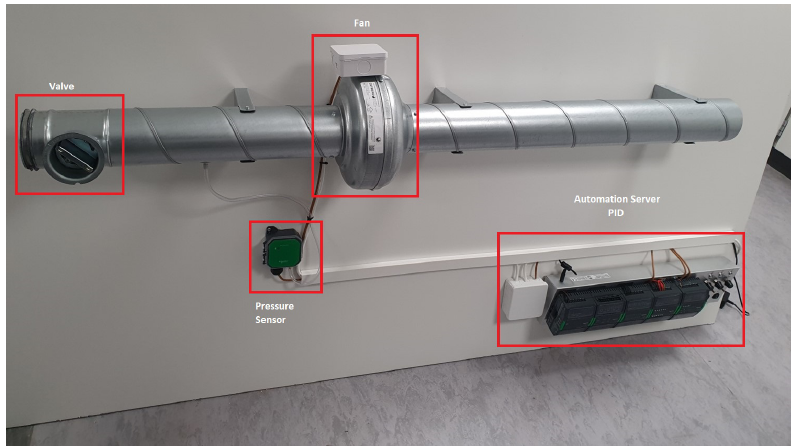
Figure 8. Overview of the fan testbed with its